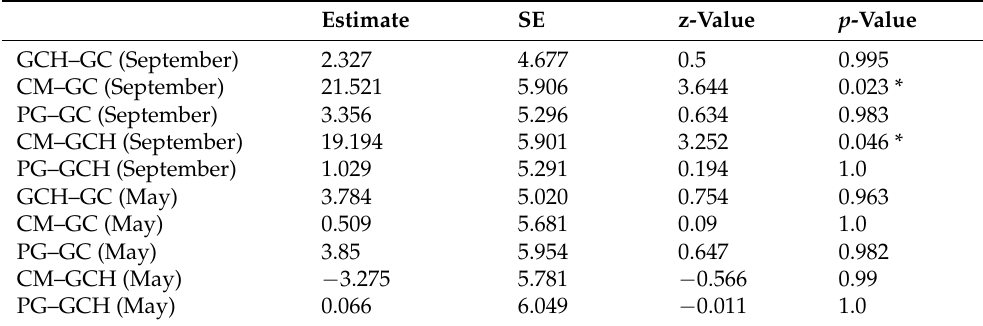
Table A13. Differences in activity densities of flying/mobile carabid beetles, comparing grass–clover (GC) and grass–clover herbs (GCH) with each other, and in comparison to conventional maize (CM) and permanent grasslands (PG) in May/June and September. p -values are indicated as * p < 0.05.